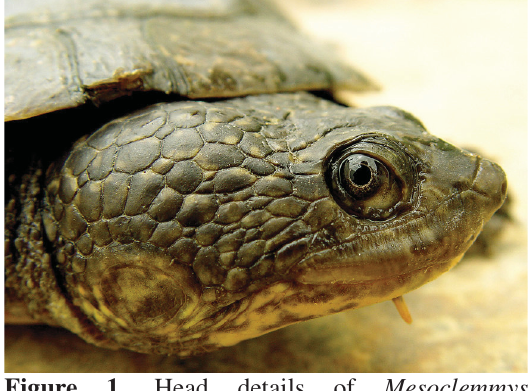
Figure 1. Head details of Mesoclemmys tuberculata collected in the Piauí state, northeastern Brazil .